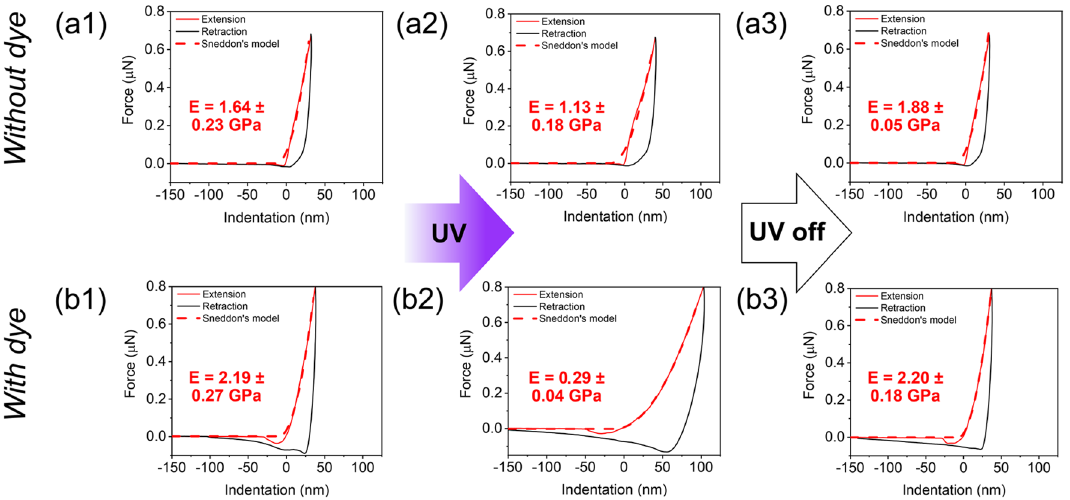
Figure 4. Force curves of chiral-nematic LCN coatings without dye ( a1 – a3 ) and with dye ( b1 – b3 ) on a glass substrate in dark ( a1 and b1 ), under UV illumination with power ~ 90 mW/cm 2 ( a2 and b2 ) and 2 min after switching off UV light ( a3 and b3